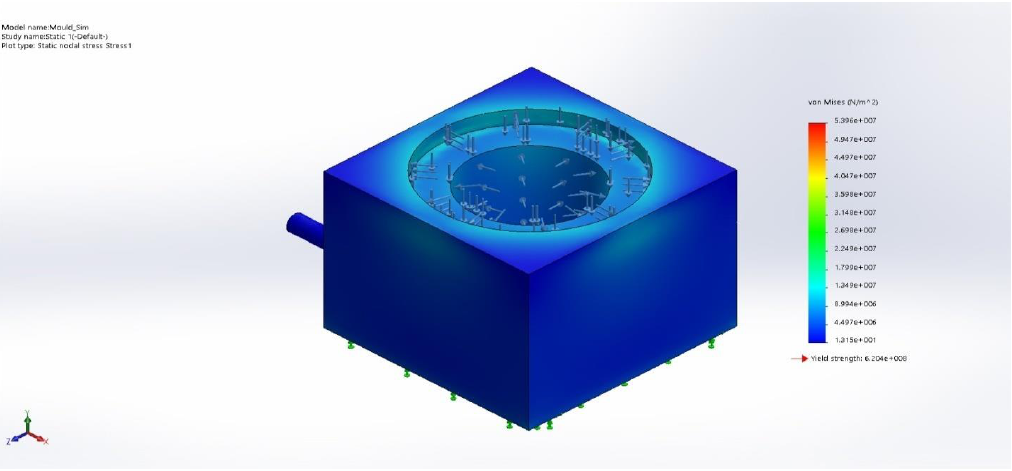
Fig.9. Stress distribution on female